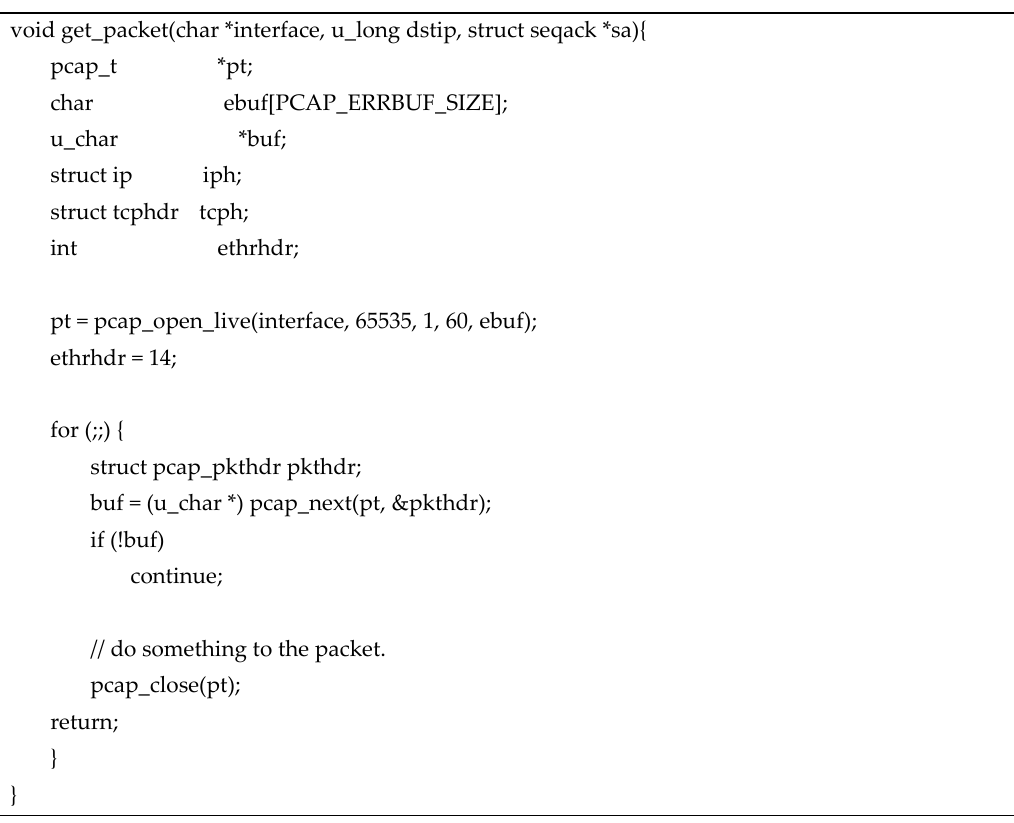
Figure 8. Acquiring packet buffer using